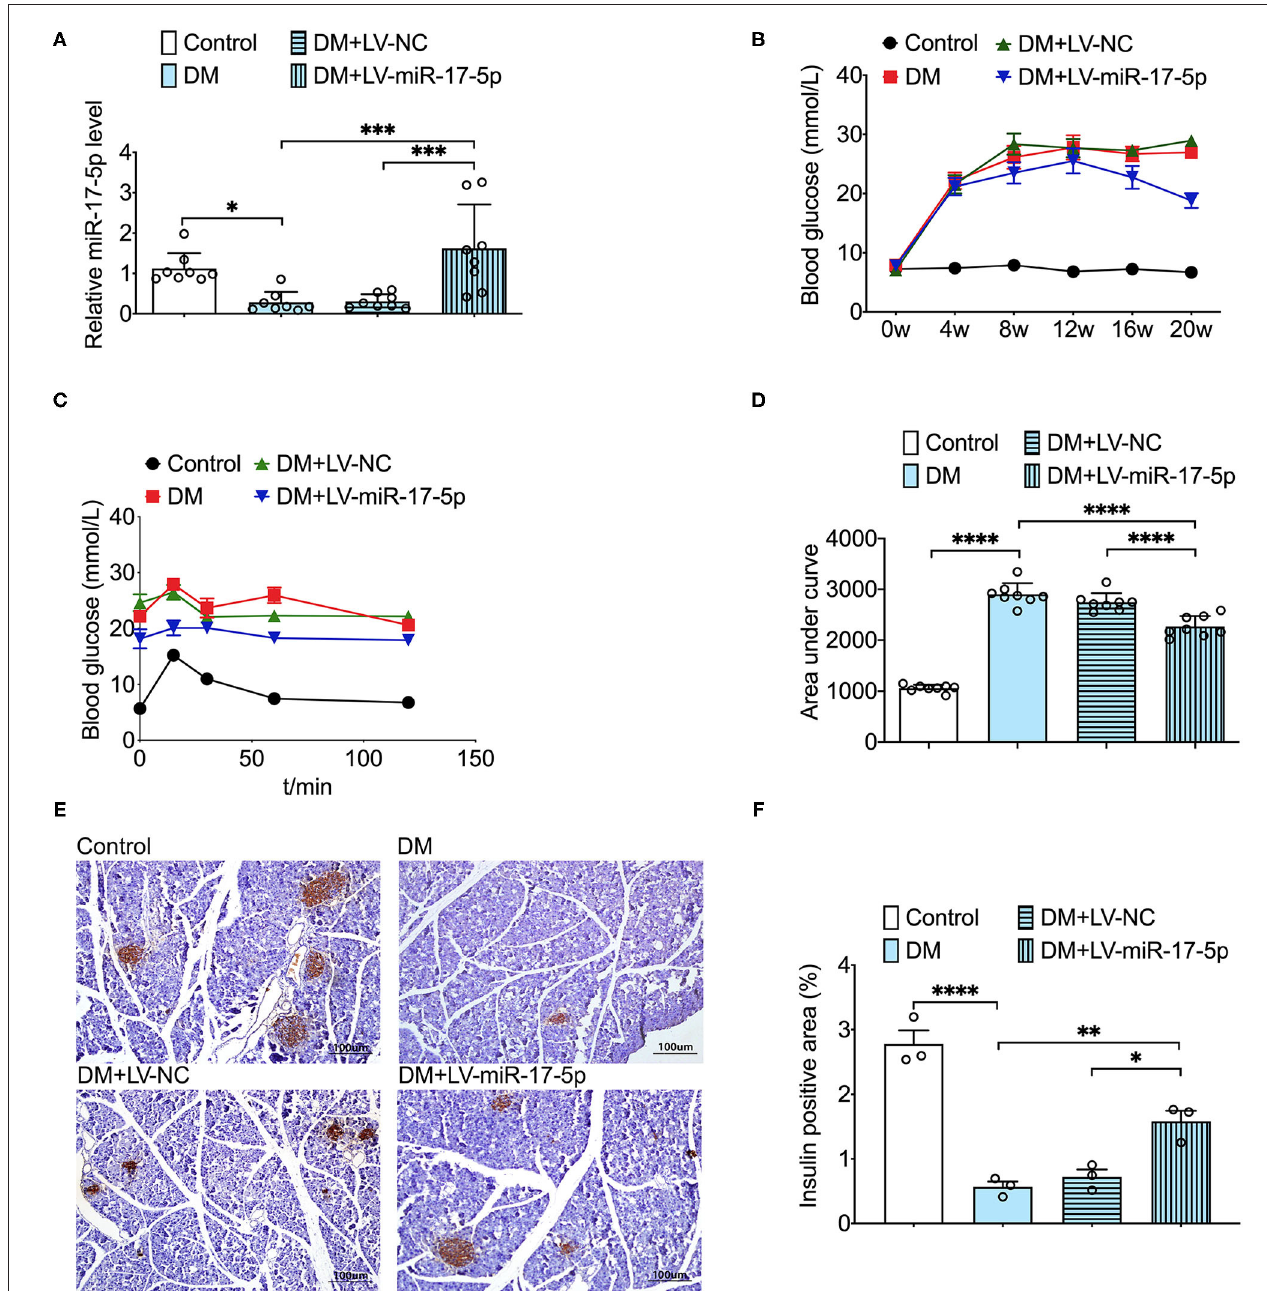
FIGURE 4 | Overexpression of miR-17-5p decreased the levels of blood glucose, improved glucose tolerance, and increased the pancreatic islet size in the DM mice. (A) The level of miR-17-5p in mice pancreatic tissue was determined by qRT-PCR ( n = 8). (B) Effects of miR-17-5p on the blood glucose levels in DM mice ( n = 8). (C,D) Effect of miR-17-5p on glucose tolerance in DM mice ( n = 8). (E,F) Pancreatic sections were immunohistochemically stained for anti-insulin (dark brown). All slides were counterstained with hematoxylin and imaged at × 10 objective magnification ( n = 3). * p < 0.05, ** p < 0.01, *** p < 0.001, and **** p <